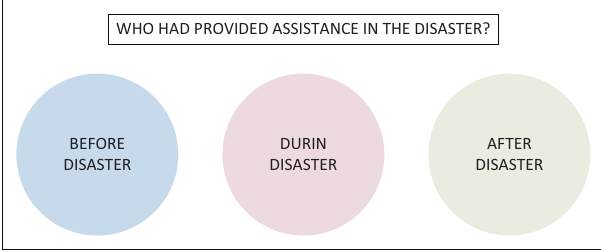
FIGURE 2: Identification of key actors in providing assistance in the disaster – Separate situations.